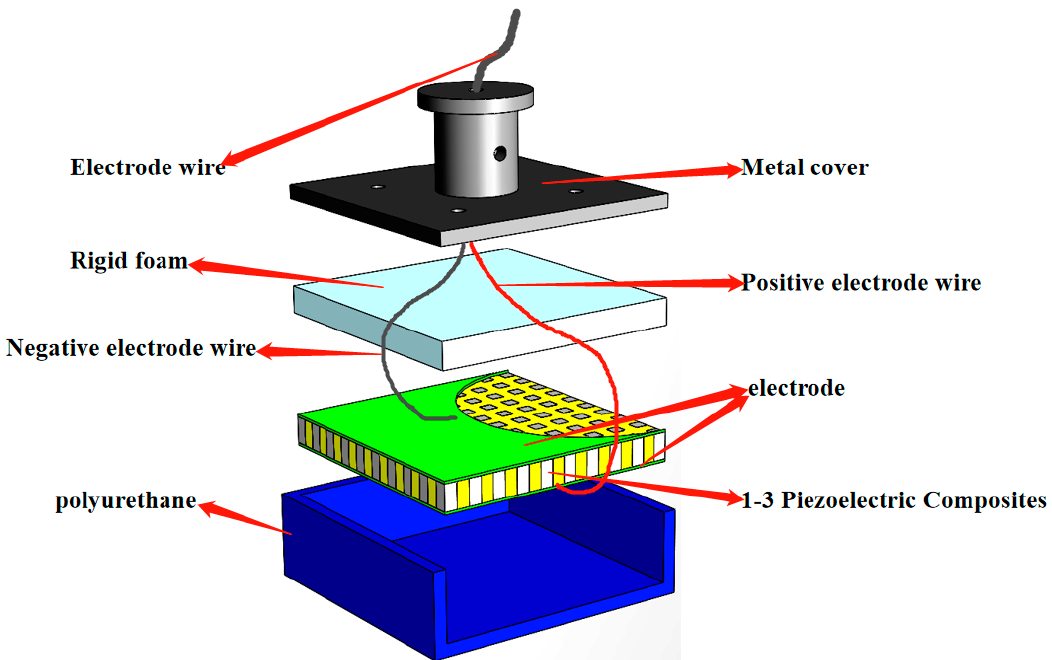
Figure 11. Exploded schematic of the planar transducer.